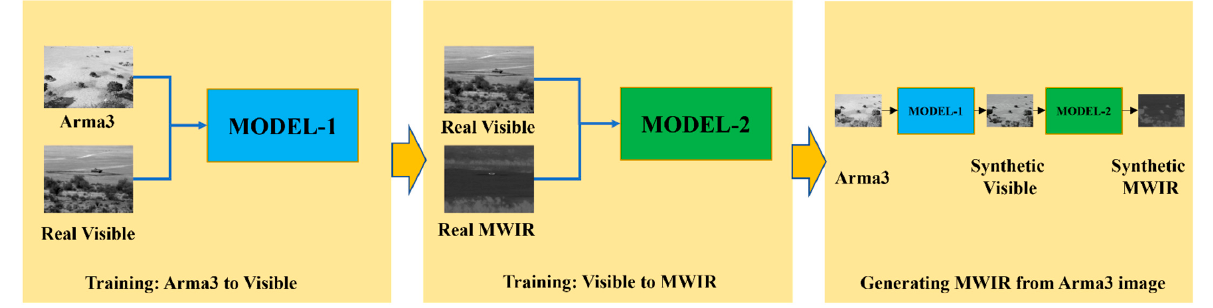
Figure 5. Illustration of the proposed two-step technique for generating MWIR images from game- engine-generated images.